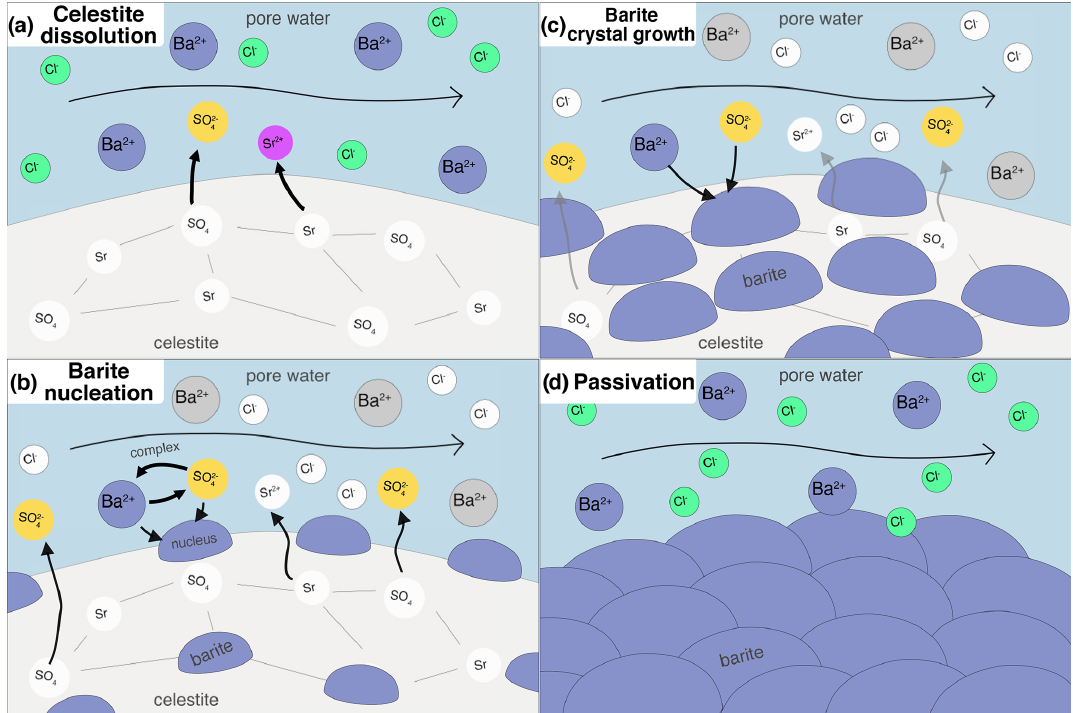
Figure 2. Conceptual illustration of the considered processes in the reactive transport simulations. (a) Celestite dissolves after BaCl 2 solution is injected into the column, as the solution is undersaturated with respect to celestite. (b) Heterogeneous barite nucleation on celestite substrate sets in after a barite supersaturation threshold is exceeded. The more celestite dissolves, the more sulfate is in solution, increasing barite supersaturation. (c) Creation of barite reactive surface area causes bulk precipitation to happen and the precipitated nuclei to grow. (d) When nucleation and crystal growth are fast, the celestite substrate may overgrow with barite crystals, leading to a passivation of the system.